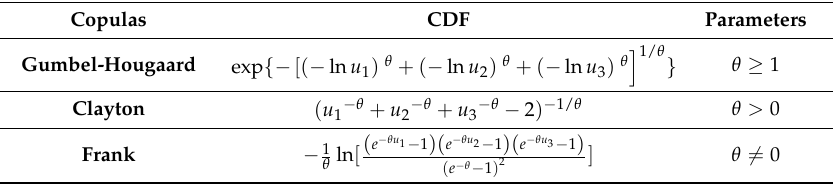
Table 2. Three-dimensional (3D) Symmetric Archimedean Copula